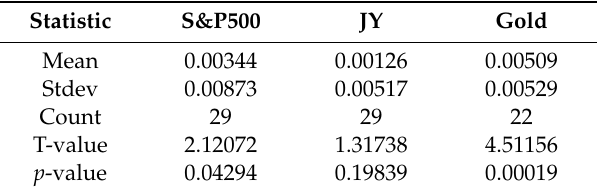
Table 11. The ($)h c-BA ’s HE—the ($) h T ’s